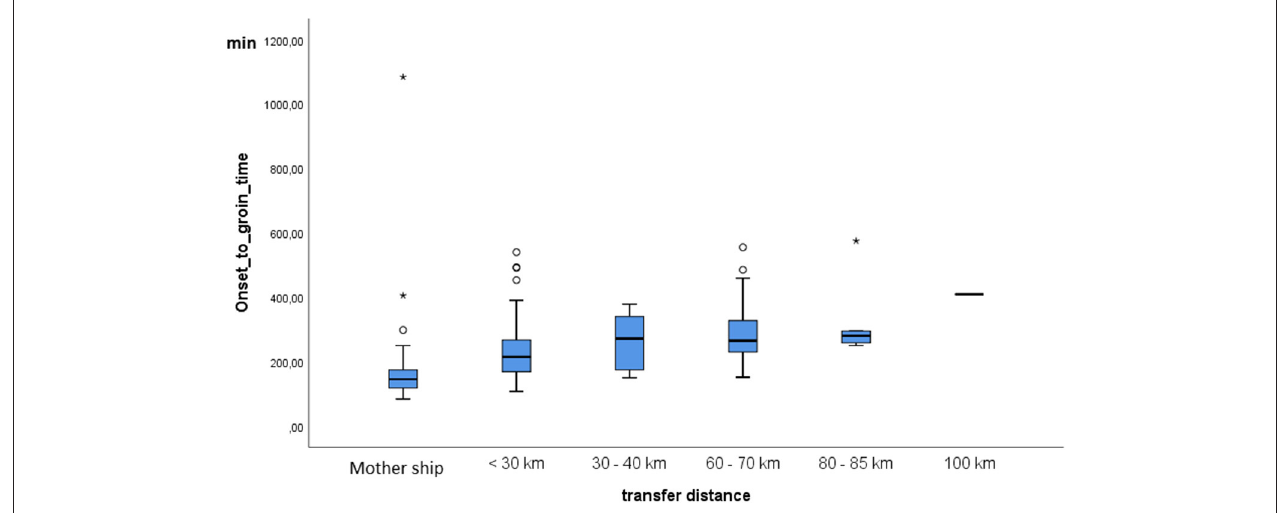
FIGURE 2 | Onset-to-groin time in dependence of transfer distance. MHH, Hannover Medical School. *Represents extreme outliers in the distribution.